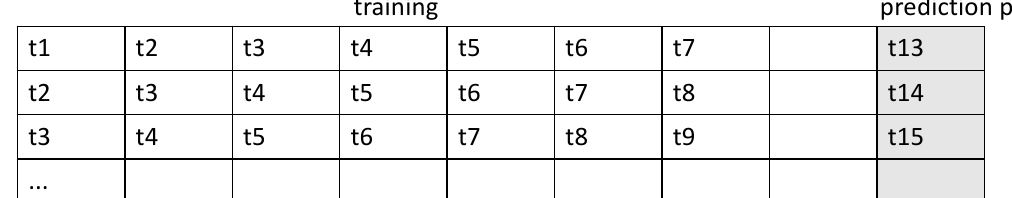
Figure 5. Form of the input sample.